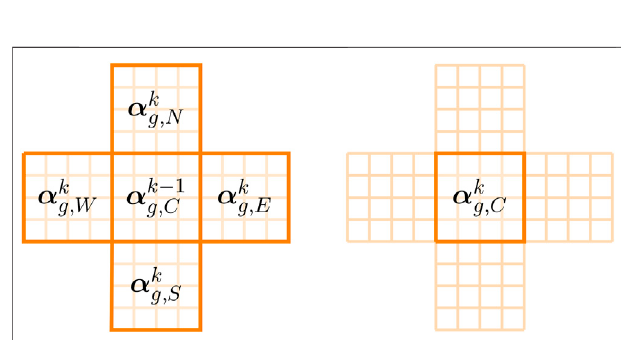
FIGURE 3| Left: reduced variables associated with the fi ve subdomains ( N , E , W , S , and C ) of the star-shaped grid at future ( k ) and current ( k − 1) time levels, which, along with the reduced variables of the buildings ( β g , C ), form the inputtotheneuralnetwork;right:thereducedvariablesofthecentralgrid at the future time level which form the output of the neural